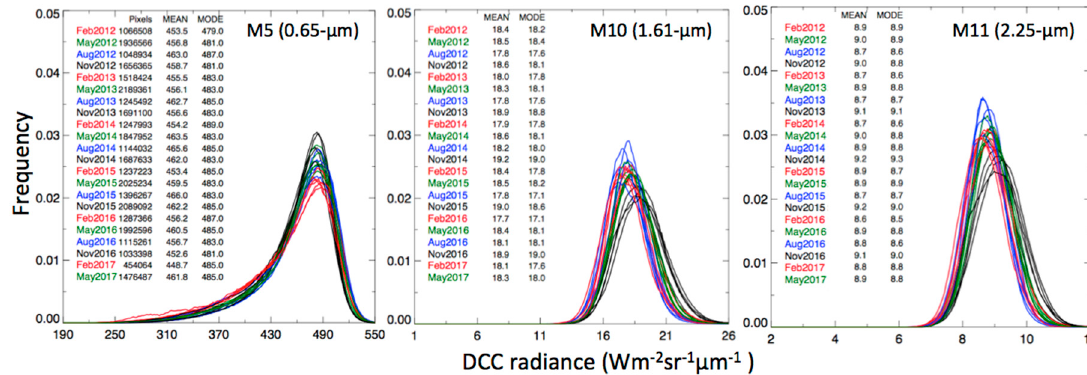
Figure 1. Monthly deep convective clouds (DCC) probability density function (PDF) radiance plots for the VIIRS: M5 band ( left panel ); M10 band ( middle panel ); and M11 band ( right panel ). The monthly number of DCC identified pixels, the PDF mean, and PDF mode DCC normalized radiance values are also listed.